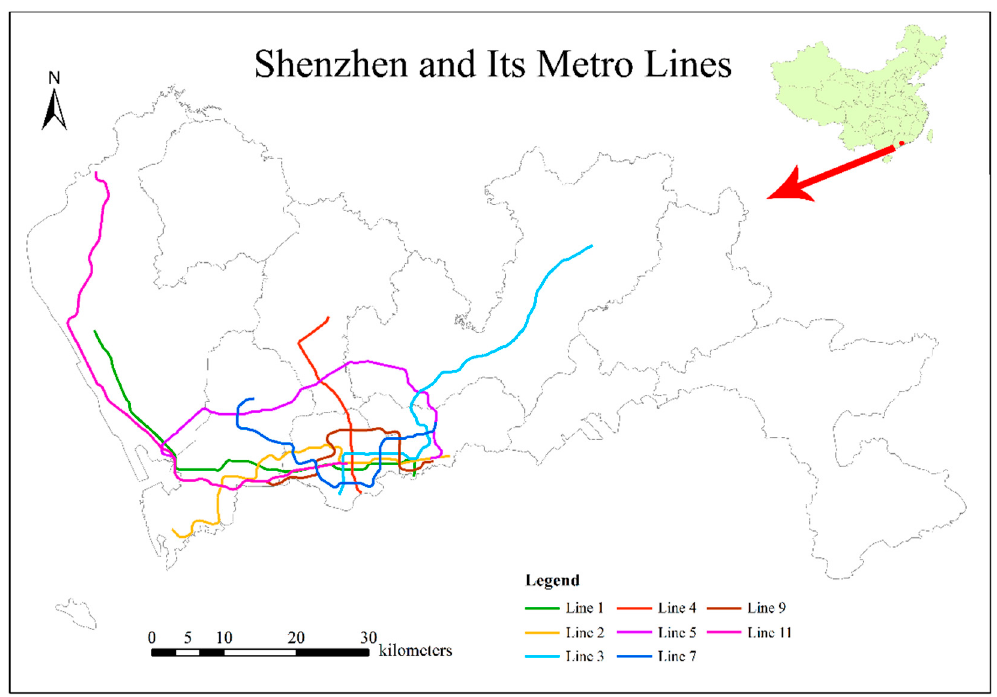
Figure 3. Study area and its metro lines.